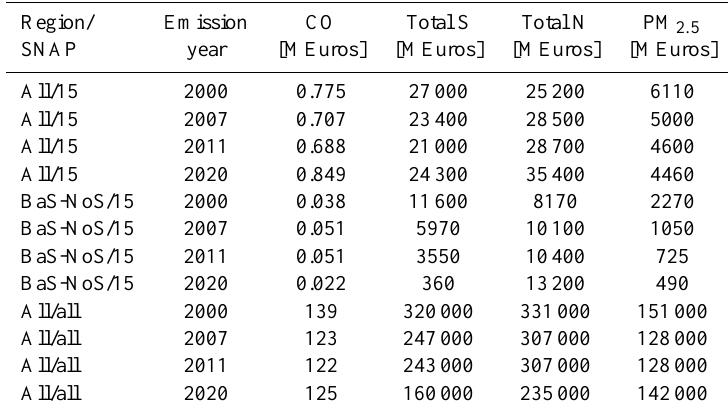
Table 5. The total external costs in million euros for the whole of Europe per chemical compound for all the different scenarios. Total S is the sum of the external cost of SO 2 and SO 2 − . Total N is the sum of the external costs of O 3 and NO − 4 are included in the impacts related to S and N through chemical reactions in the atmosphere.